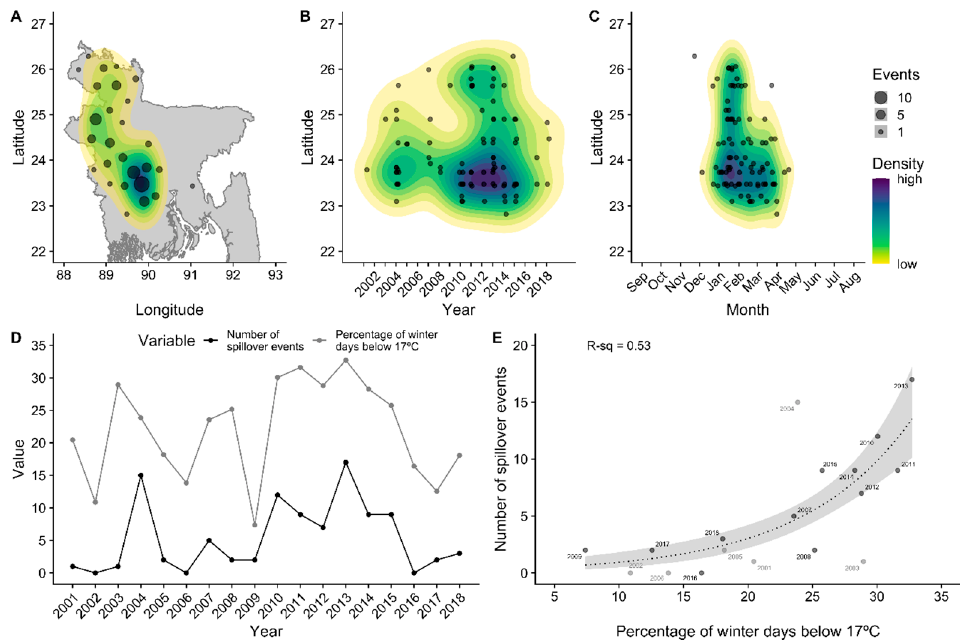
Figure 1. Spatiotemporal patterns of Nipah virus spillover events across Bangladesh, 2001–2018. Color contours in panels ( A – C ) show the spatial density of events estimated with a bivariate normal kernel. Panels ( D , E ) show the variation in the number of Nipah spillover events across years and the association with cold winter temperatures. Gray dots in panel ( E ) show the years before systematic Nipah virus surveillance.